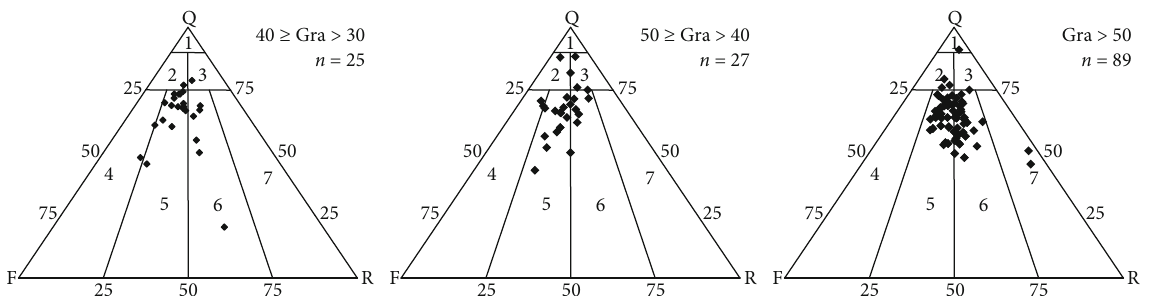
Figure 2: Sandstone classi fi cation of Zhuhai Formation in di ff erent geothermal gradient regions: (1) quartzarenite, (2) subarkose, (3) sublitharenite, (4) arkose, (5) lithic arkose, (6) feldspathic litharenite, and (7) litharenite.